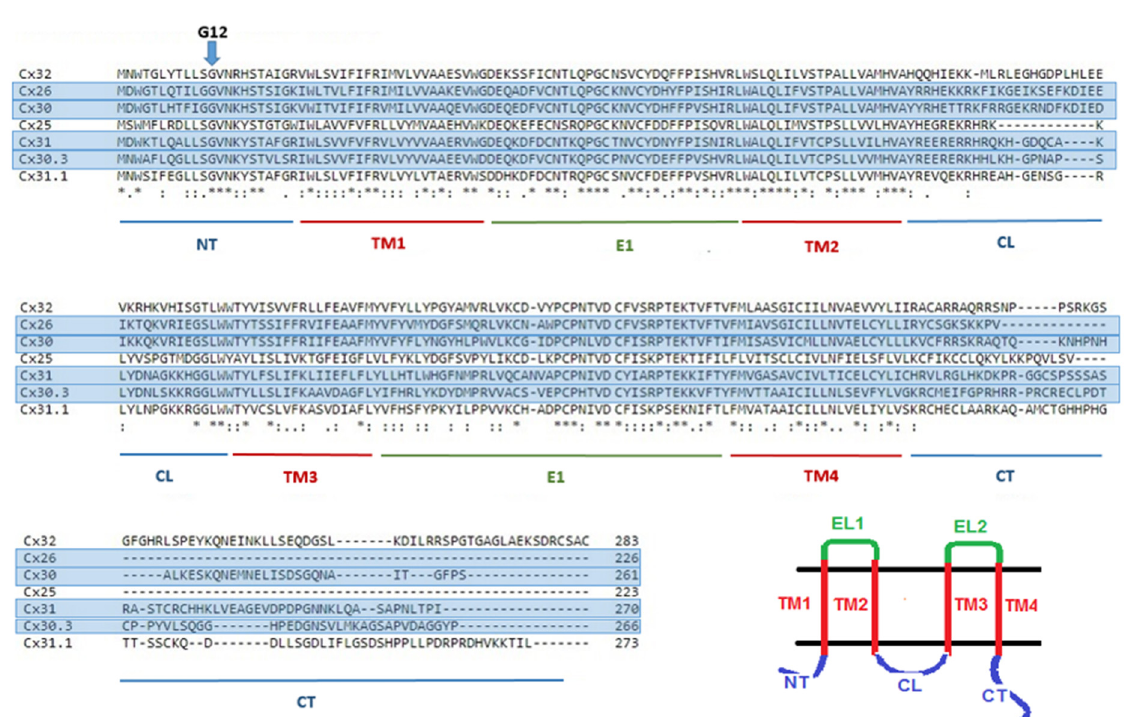
Figure 1. Amino acid alignment of beta-connexins. All include a glycine at position 12 which is located about halfway through the amino terminus and is one of only three conserved glycines. Cx26, Cx30, Cx30.3 and Cx31 (blue highlight) are coexpressed in the stratum granulosum and are associated with hereditary skin disorders. Sequences were aligned using Clustal Omega [4]. Inset: Membrane topology of a connexin protein four transmembrane domains in red (TM1-TM4), two extracellular loops in green (EL1 and EL2) and cytoplasmic domains in blue (NT = amino terminus; CL = cytoplasmic loop and CT = cytoplasmic tail).